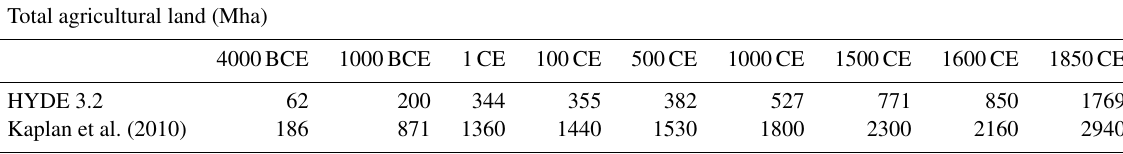
Table 7. Comparison total agricultural land estimates: HYDE 3.2 and Kaplan et al. (2011). Total agricultural land (Mha)